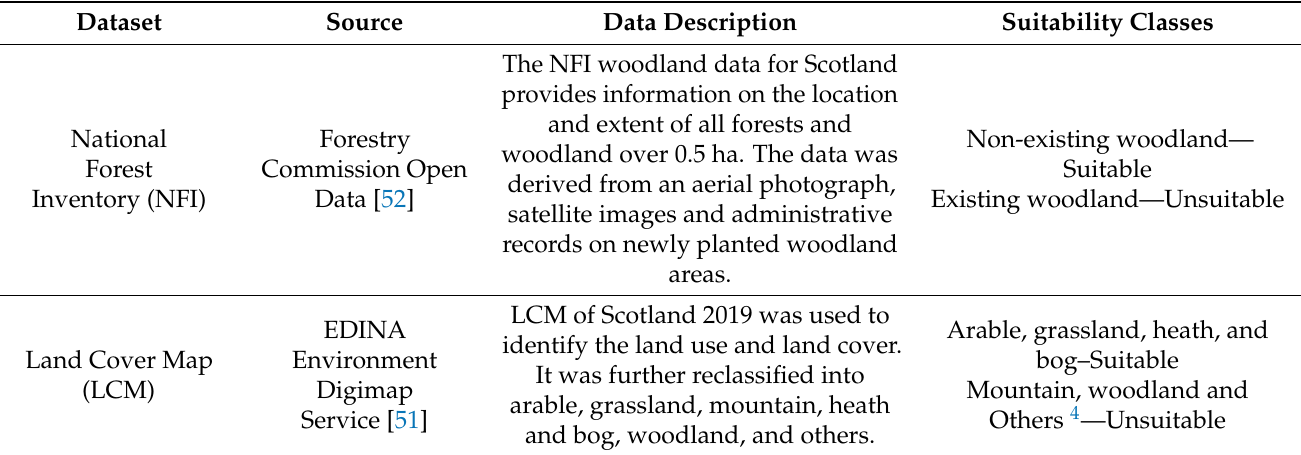
Table 4. Description of the NFI and LCM data